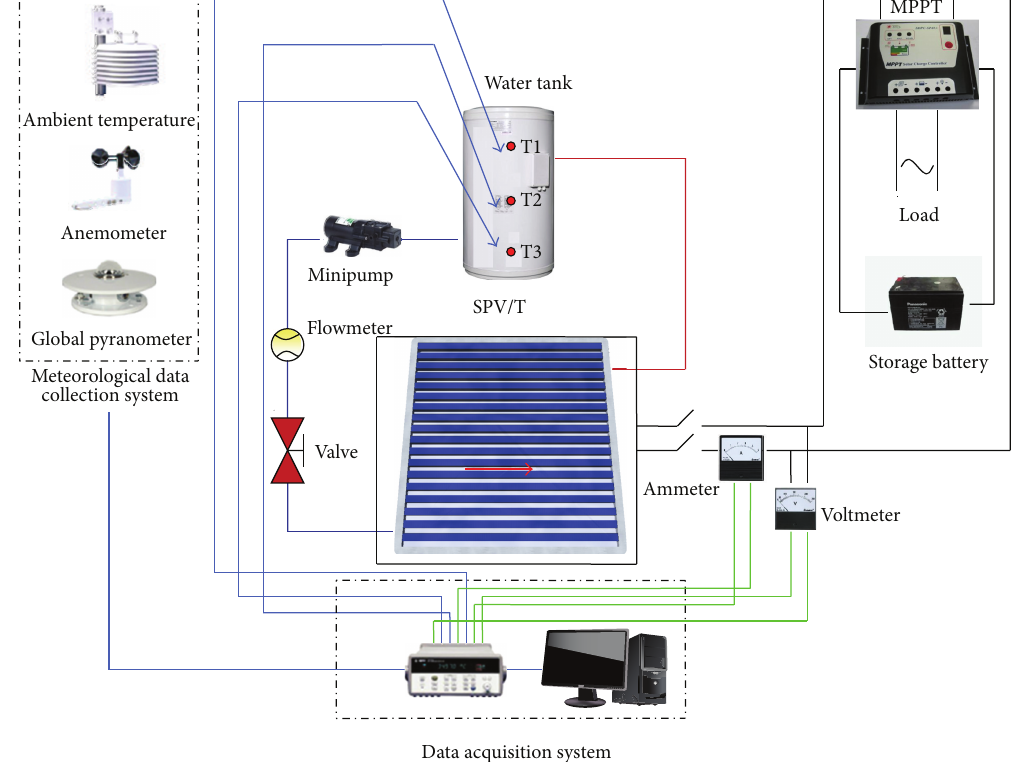
Figure 3: Testing schematic diagram of SPV/T